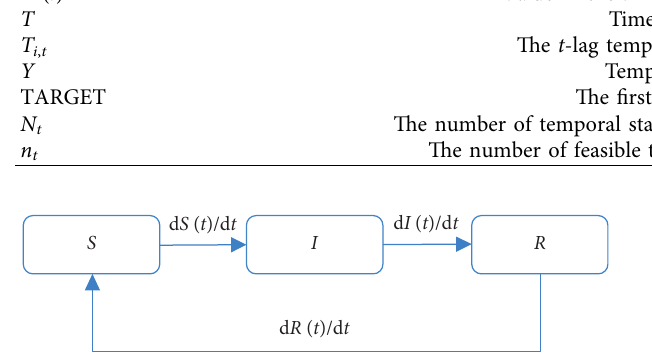
Figure 1: Example network.